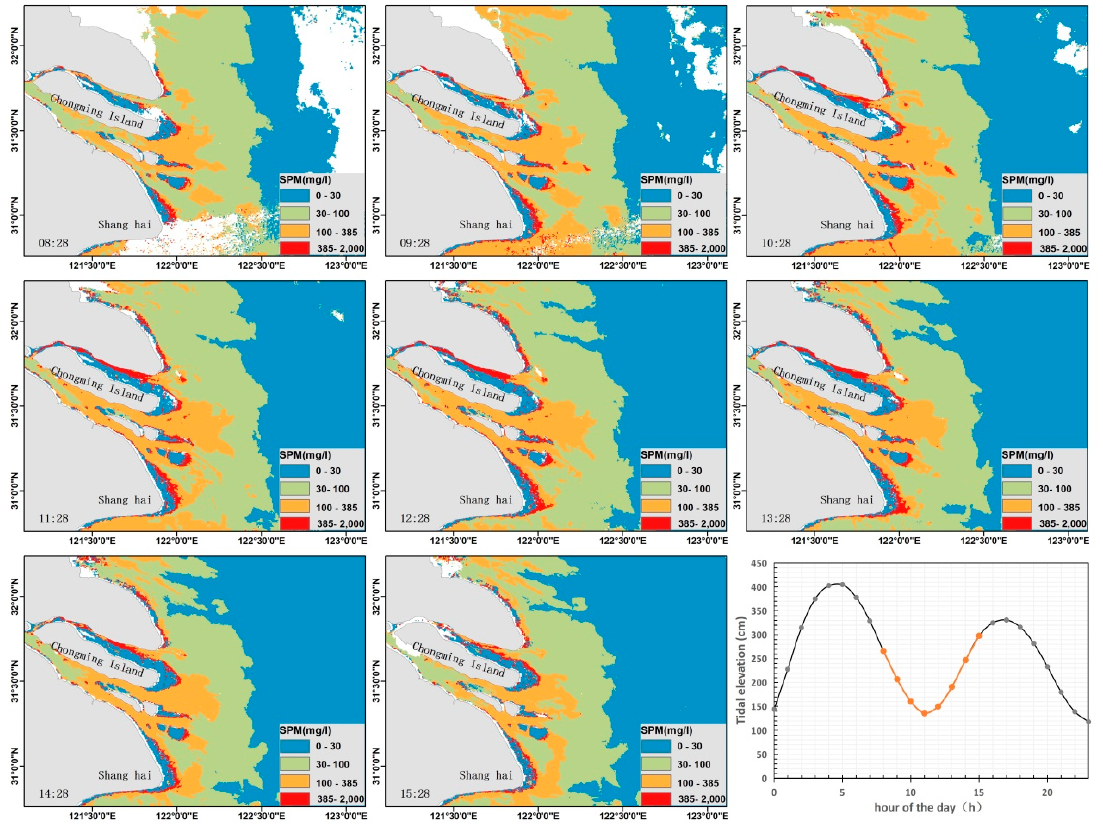
Figure 6. Hourly maps of SPM concentration in the Changjiang Estuary derived from GOCI on 16 March 2016. The labeled time in the image corresponds to the observation time in Beijing Time. The subplot at the lower right corner shows the hourly tide elevation from the tidal tables of the “Luchaogang” tide gauge station in the same day of the GOCI image.